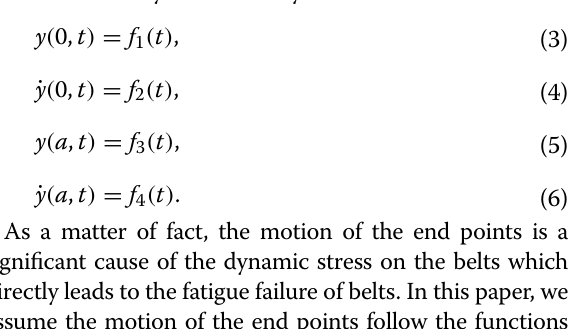
the transverse vibration and the longitudinal tension.